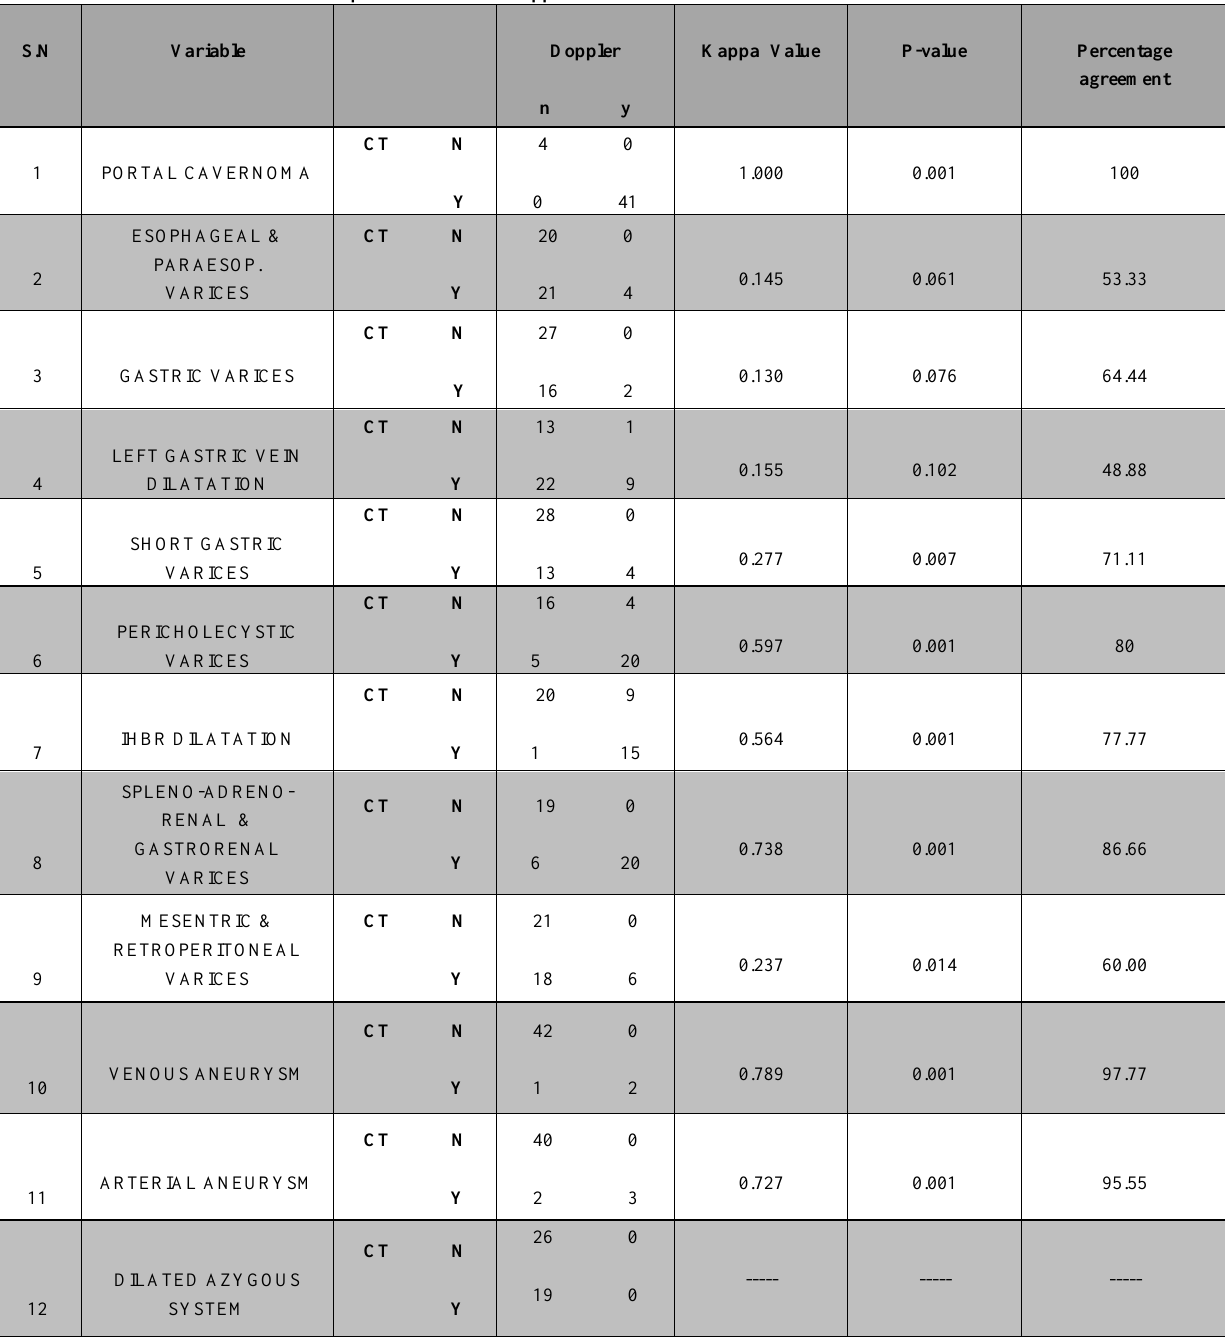
Table 1. Comparison of Colour Doppler and MDCT in evaluation of various